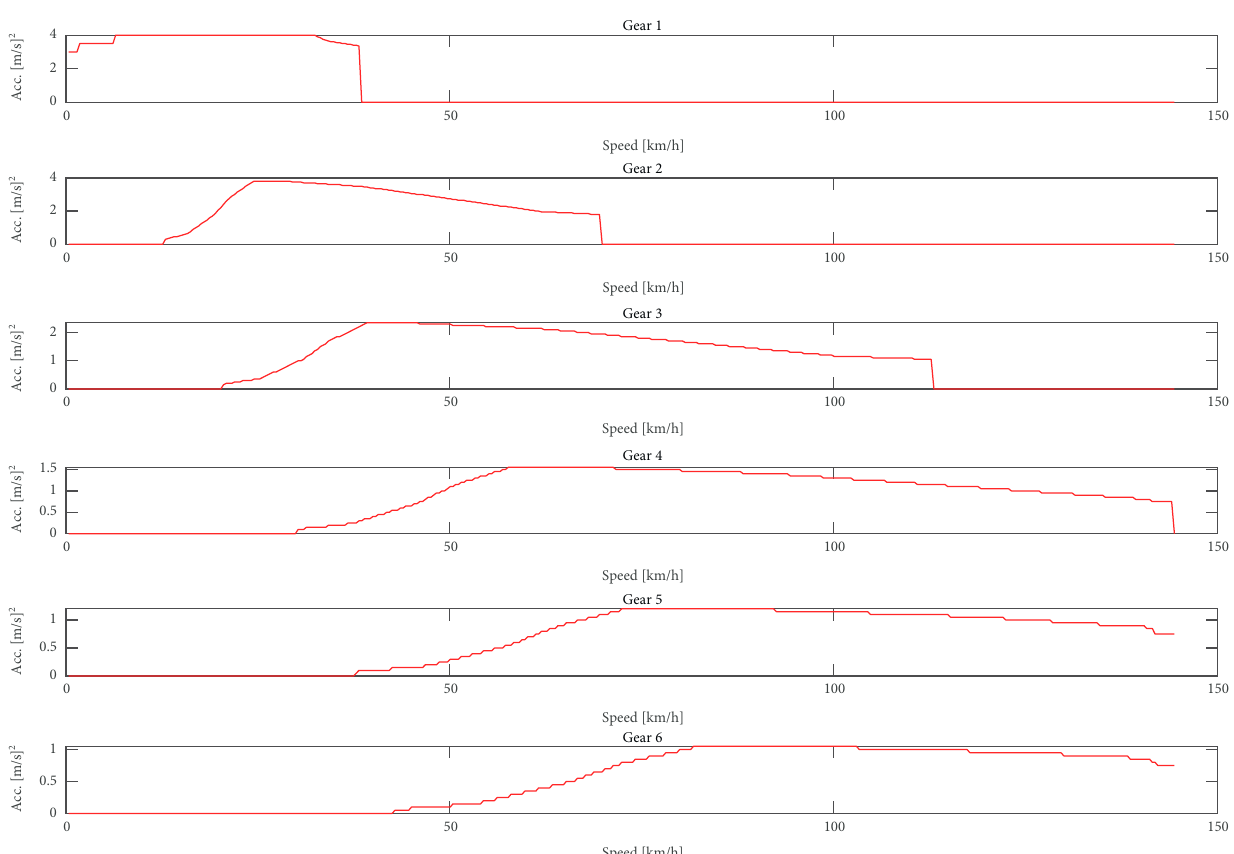
Figure 12: Maximum acceleration available [m/s 2 ] for a 6 gear diesel engine for all possible combinations of speed and